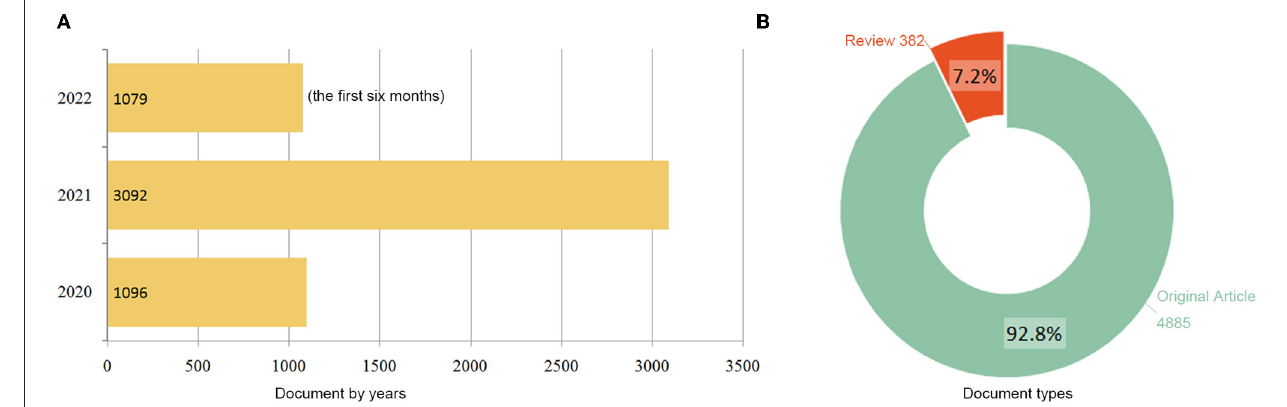
FIGURE 2 | Distribution of publications by year (A) and type (B) .